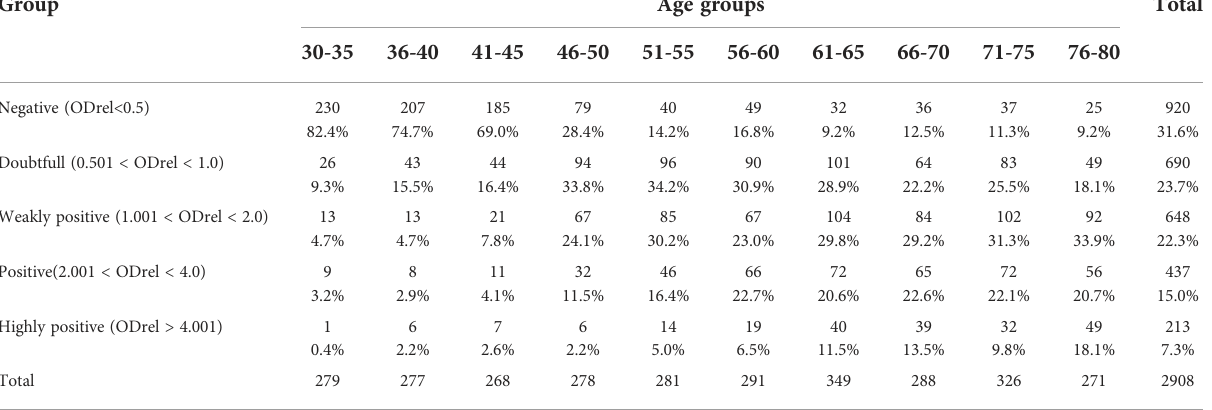
TABLE 1 Percentages of optical density values for different groups depending on the age of the study participants. Group